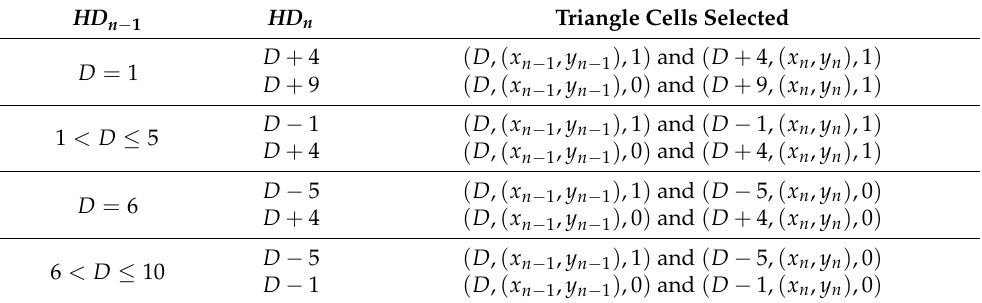
Table 15. Htotcode rule of the ( n − 1)th hexagon cell E 3 . HD n − 1